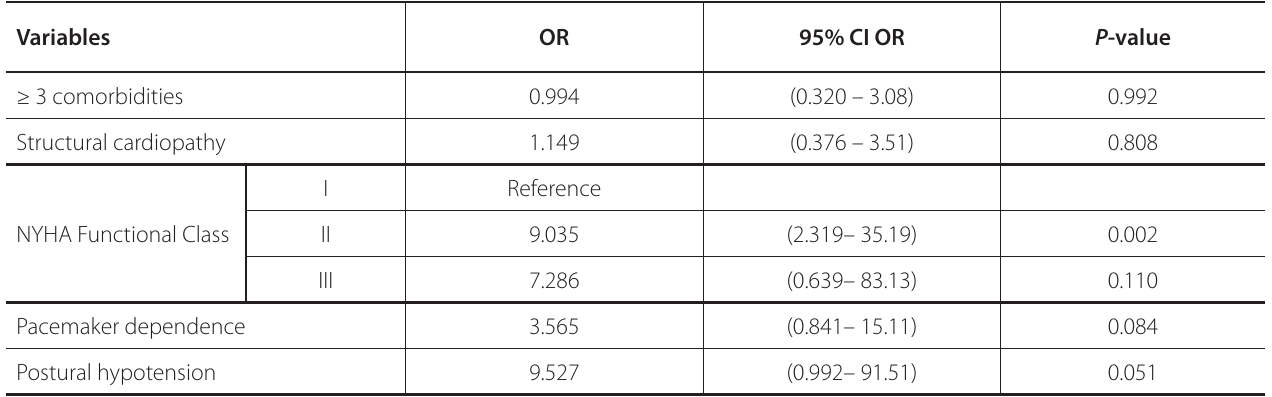
Table 4 . Multivariate logistic regression analysis of variables of syncope occurrence in patients with pacemaker. Variables OR